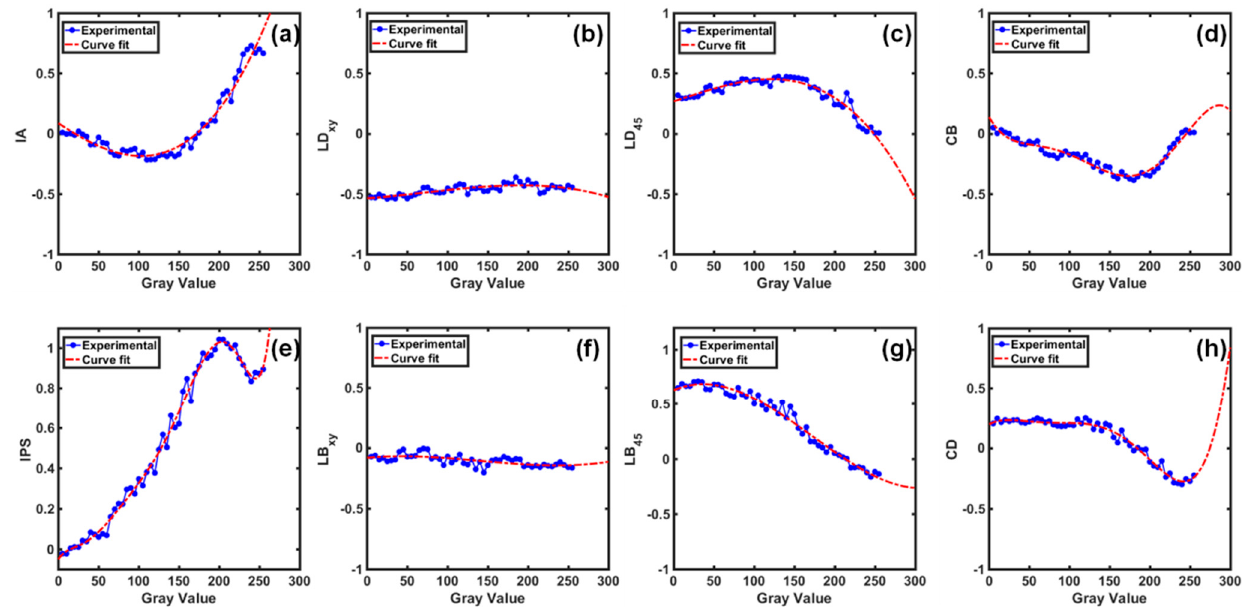
Figure 9. Anisotropic properties of the SLM as a function of its grayscales. ( a ) IA: isotropic absorption, ( b ) LDxy: linear dichroism along the xy axis, ( c ) LD 45 : linear dichroism along ±45 axes, ( d ) CB: circular birefringence, ( e ) IPS: isotropic phase shift, ( f ) LBxy: linear birefringence along the xy axis, ( g ) LB45: linear birefringence along ±45 axes, ( h ) CD: circular dichroism. Red dotted line represents the optimized curve fit for the experimental data.